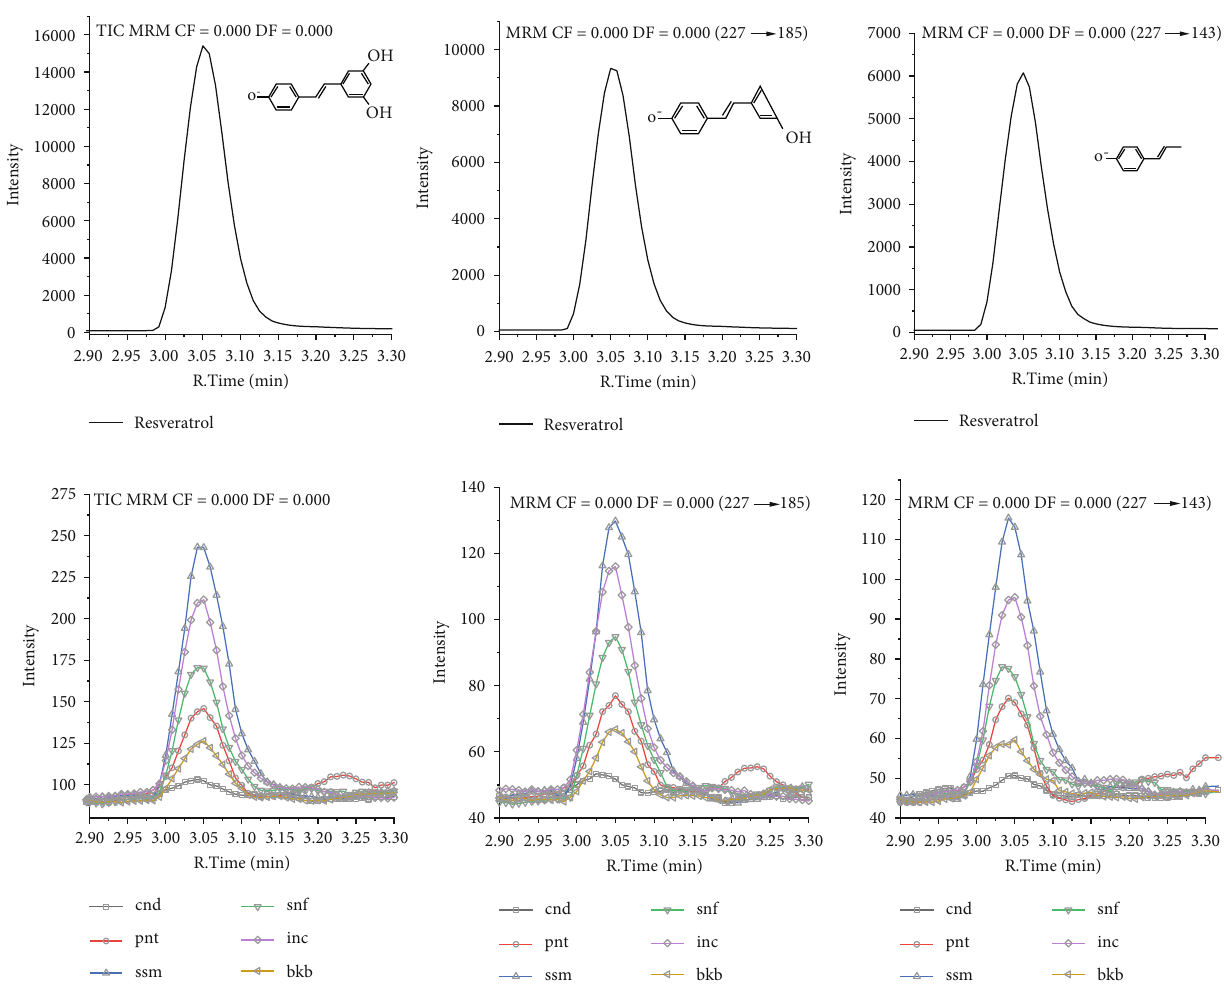
Figure 4: LC-MS/MS spectra of candlenut (cnd), peanut (pnt), sesame (ssm), sun fl ower (snf), sacha inchi residue (inc), black bean (bkb), and fragment ion of